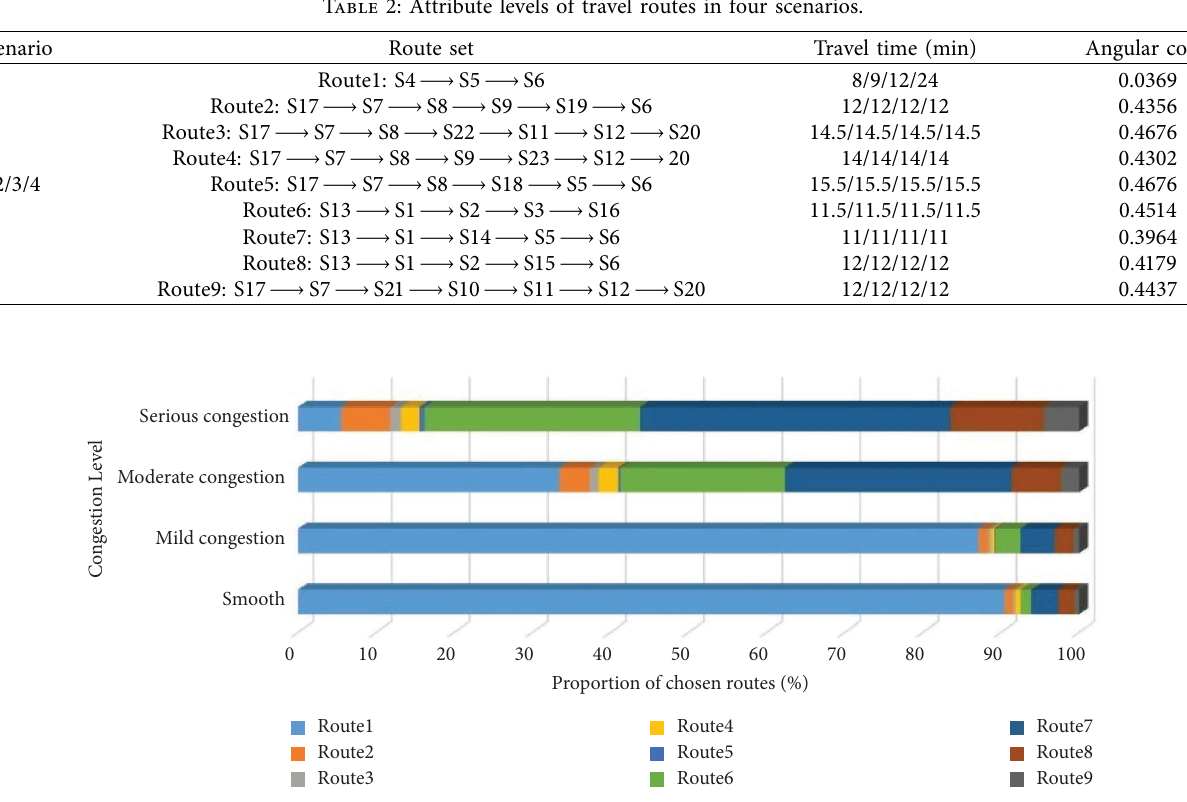
Figure 3: Proportion of chosen routes under four congestion-level